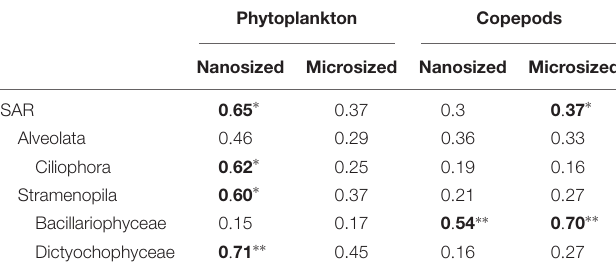
TABLE 1 | Correlation analyses show a significant impact of phytoplankton on nanosized community, while Copepods impacted microsized plankton, and the Bacillariophyceae (significant correlation is in bold: ∗ p < 0.05; ∗∗ p < 0.01).